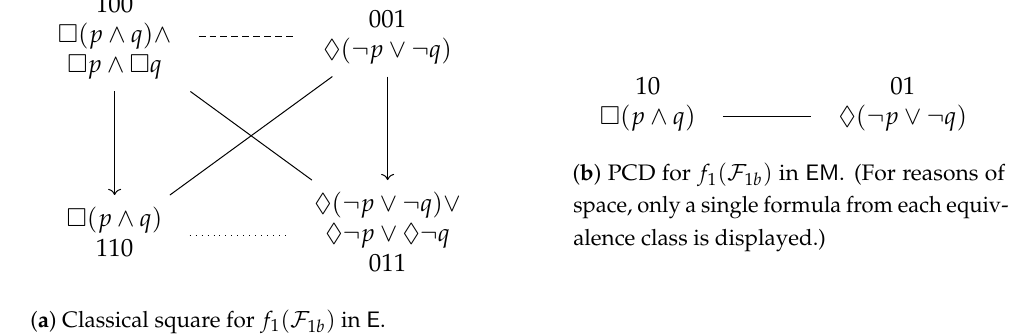
Figure 8. Aristotelian diagrams for f 1 ( F 1 b ) = { (cid:3) ( p ∧ q ) ∧ (cid:3) p ∧ (cid:3) q , (cid:3) ( p ∧ q ) , ♦ ( ¬ p ∨ ¬ q ) , ♦ ( ¬ p ∨ ¬ q ) ∨ ♦ ¬ p ∨ ♦ ¬ q } in two non-normal modal